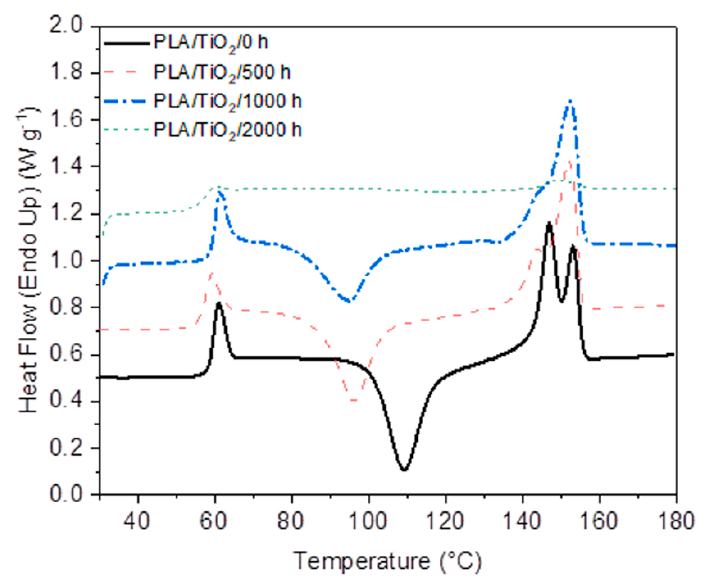
Figure 12. DSC first heating curves of PLA / TiO 2 nanocomposite after accelerated weathering degradation. Table 3. DSC data obtained for neat PLA and PLA / TiO 2 nanocomposite after accelerated weathering degradation. Melting Degree Glass Transition